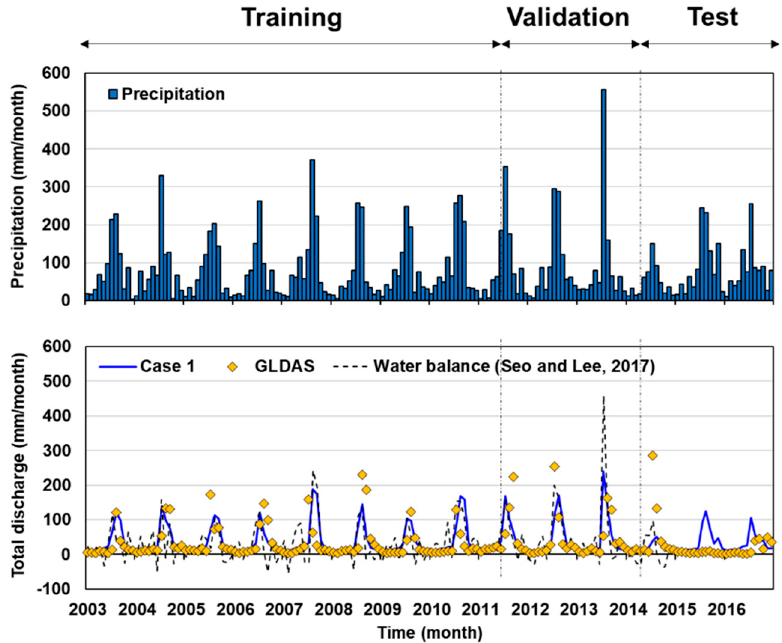
Figure 10. Total discharge results (ANN-predicted, GLDAS, and water balance-based) with observed precipitation for North Korea.